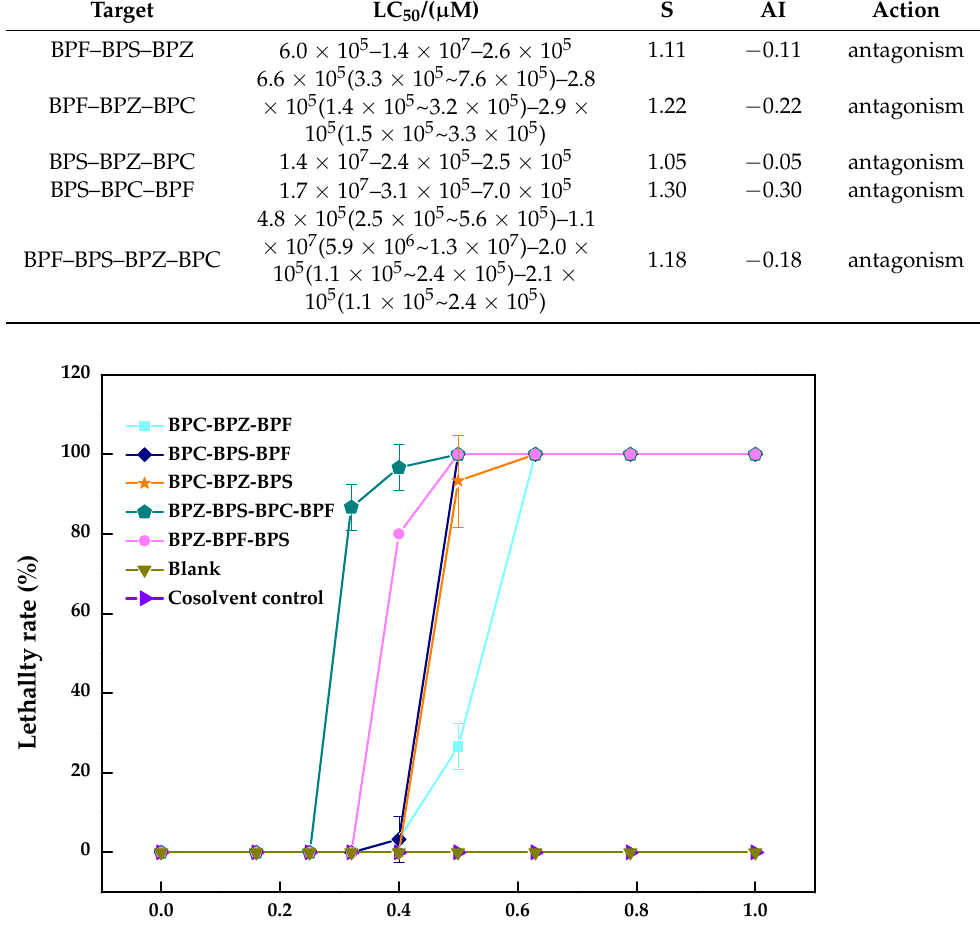
Table 3. Multi-joint acute toxicity of BPZ, BPC, BPF, and BPS on zebrafish after 96 h.